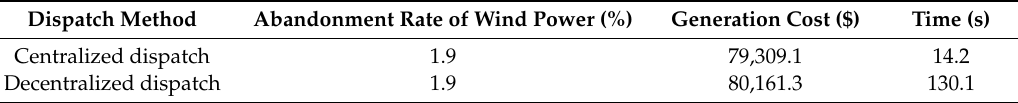
Table 2. Comparisons for 2-area 6-node interconnected test system.